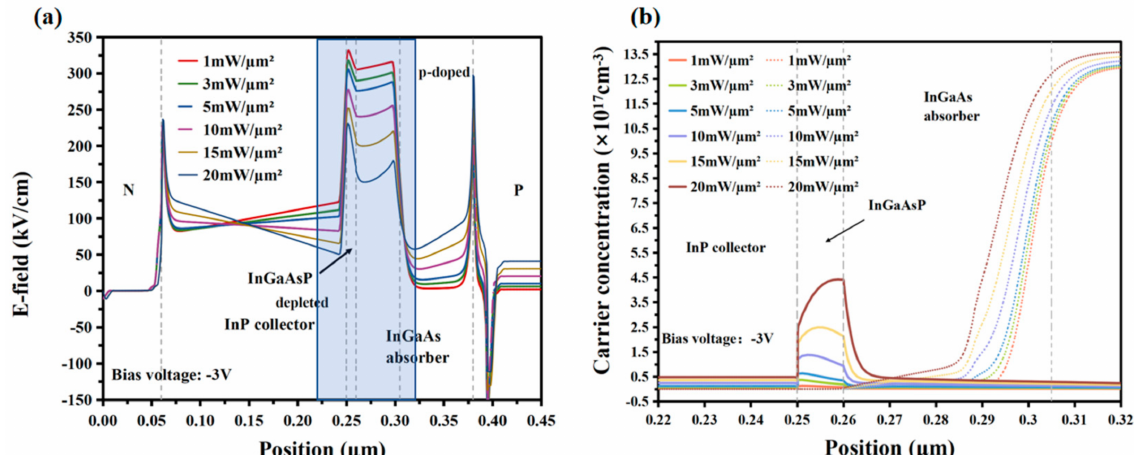
Figure 5. ( a ) APSYS–simulated electric field distribution (the direction of the E field is along the positive x –axis); ( b ) simulated carrier distribution (solid: electron; dot: hole) for the shaded region in Figure